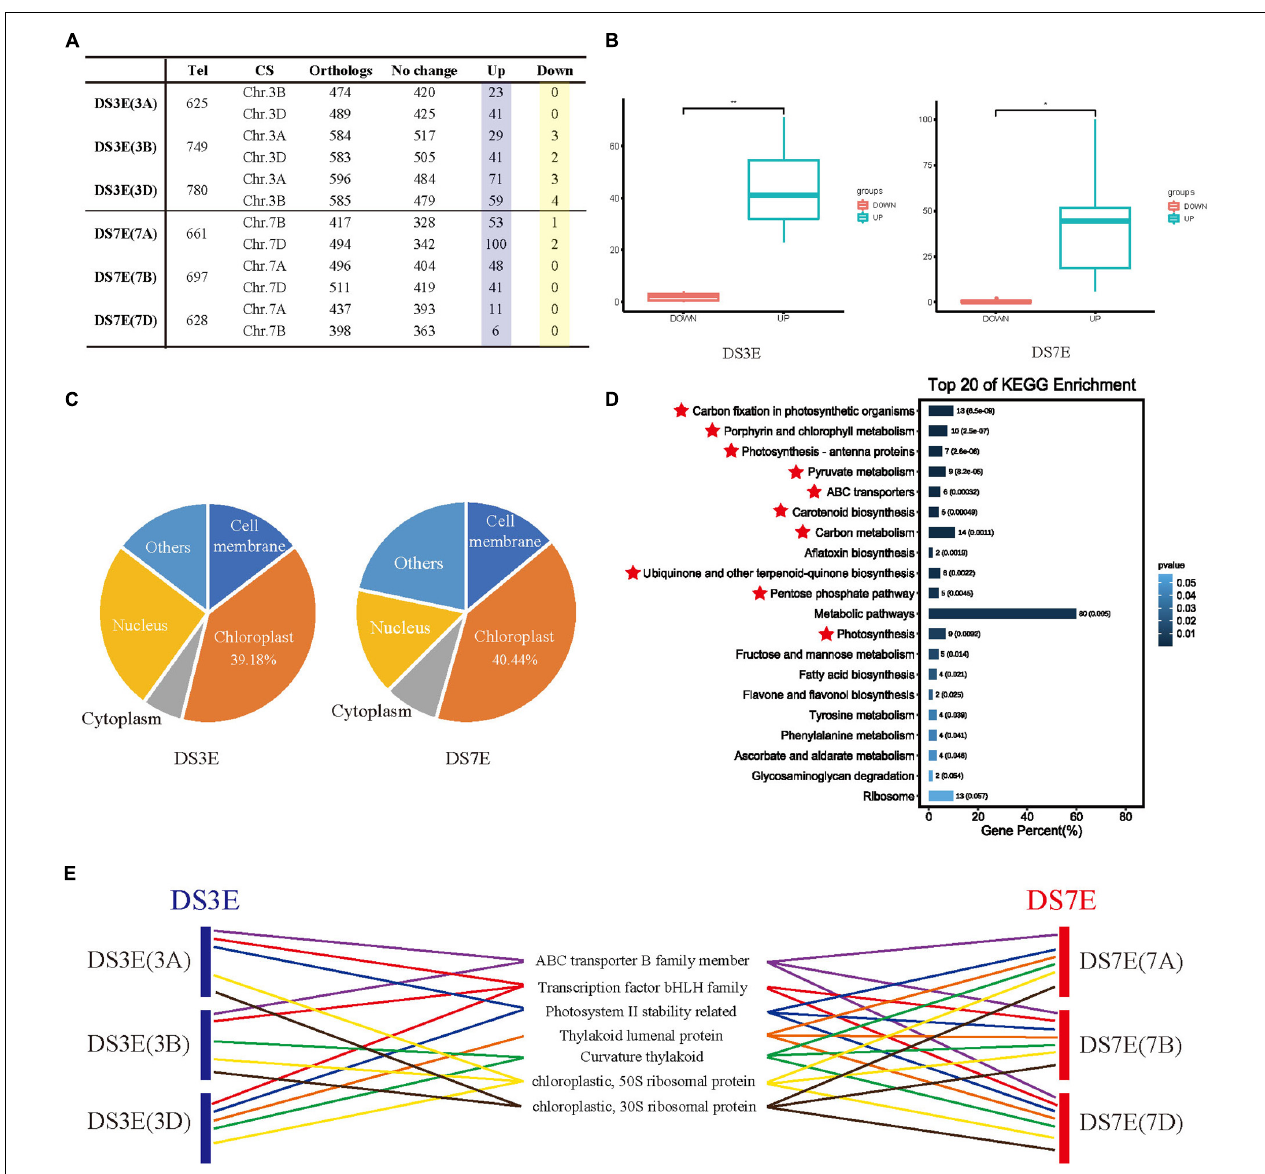
FIGURE 2 | Transcriptional changes and functional analysis of CS homeologous genes in DS3E and DS7E. (A) The differential transcription of CS orthologs of upregulated genes in DS3E and DS7E. (B) Comparison of upregulated and downregulation of CS homologous genes. Statistical analysis was performed using the T -test method. * p < 0.05. ** p < 0.01. (C) Subcellular localization of CS homologous genes. (D) Kyoto Encyclopedia of Genes and Genomes (KEGG) enrichment of wheat homologous genes. The photosynthesis-related genes with p < 0.01 were marked by the red star. (E) Distribution of photosynthesis-related genes in different substitution lines. Different items were represented by different color lines. The same item was represented by a line of the same color between different substitution